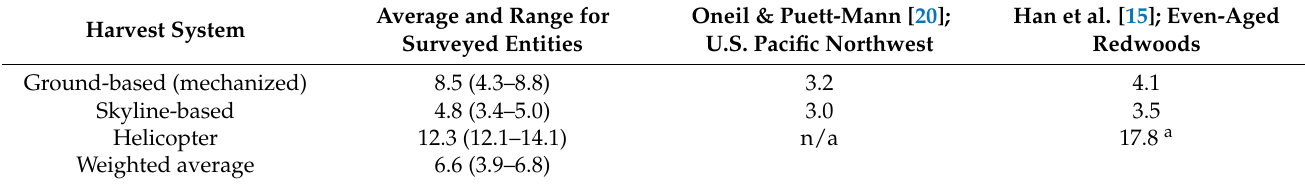
Table 3. Average and range of fuel consumption recorded (liter per m 3 of harvested sawlog volume). Ranges provided in brackets by surveyed entity. Ground-based systems reflect mechanized systems dominated by feller-bunchers, shovel yarders, boom processors, and (truck) loaders. Lubricant consumption was not considered (<1% of fuel